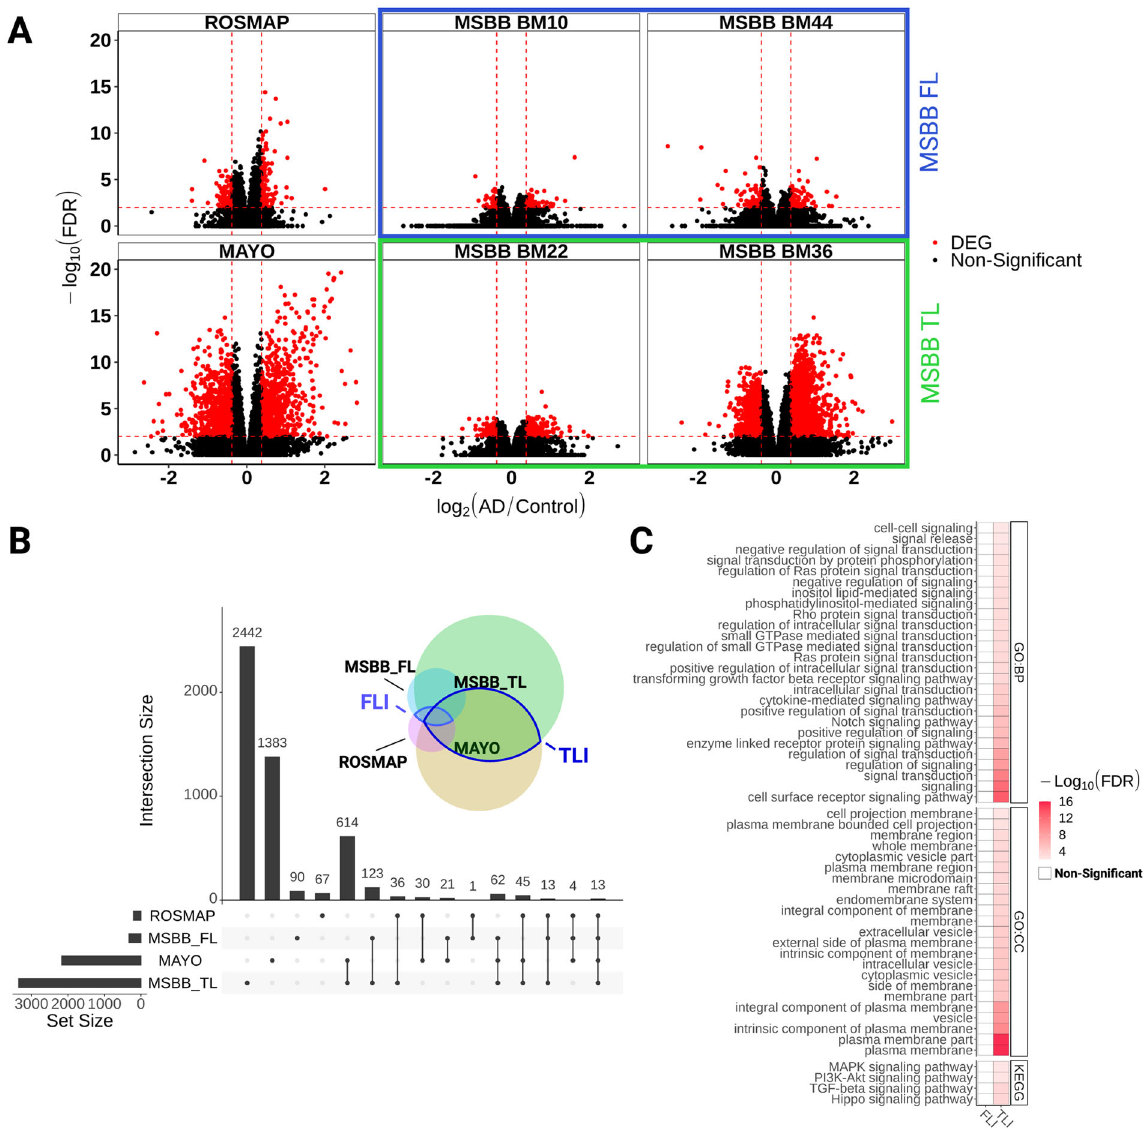
Fig. 2 Gene expression alterations are more prominent in the temporal than the frontal lobe of AD patients. A Volcano plots showing differentially expressed genes (DEG, red dots; FC > 1.3 and FDR < 0.01) in the frontal lobe (ROSMAP and MSBB FL - BM10 and BM44) and temporal lobe (Mayo and MSBB TL - BM22 and BM36). B Upset plot showing the total number of DEGs identi fi ed in each dataset (horizontal bars) and the number of DEGs exclusive of one dataset ( fi rst four vertical bars) or shared by different datasets (other vertical bars). Black dots below vertical bars indicate datasets quanti fi ed. Venn diagram illustrates the same results in colors and circle sizes. C Gene ontology terms enriched for DEGs identi fi ed in the TL or FL intersections (TLI and FLI,